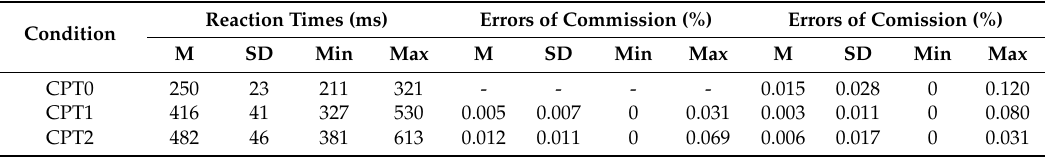
Table 1. Descriptive statistics of reaction times, errors of commission, and errors of omission in the three conditions of the continuous performance test (CPT) in 110 participants. No errors of commission were possible in the CPT0